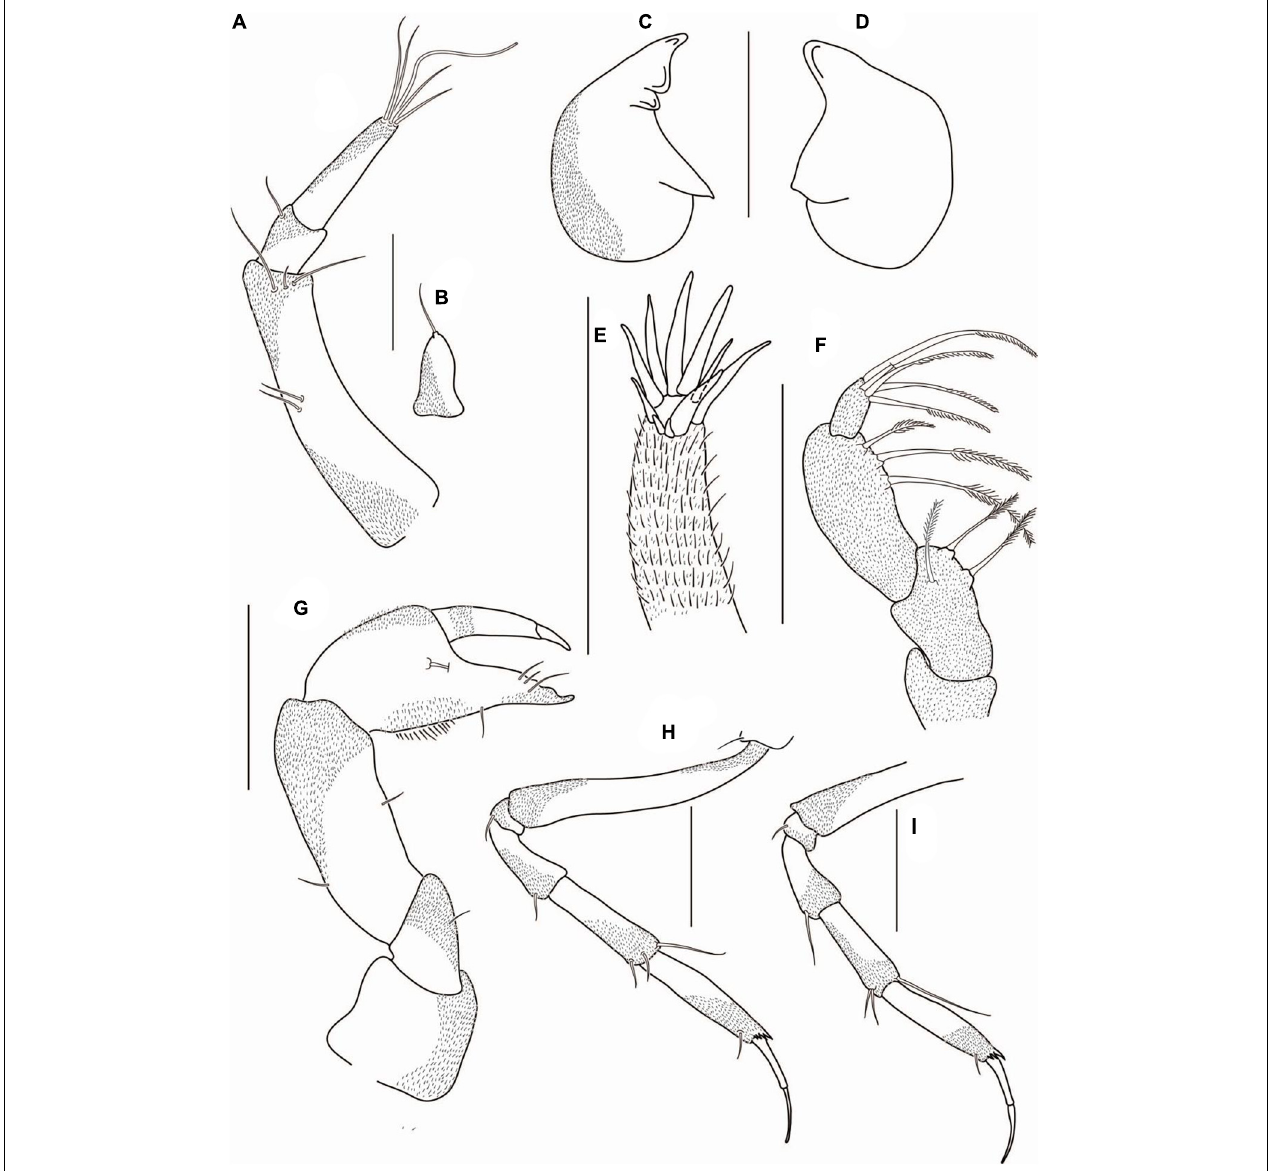
FIGURE 12 | Agathotanais oharai n. sp., neuter, paratype (NMV J 74742); (A) antennule; (B) antenna; (C) left mandible; (D) right mandible; (E) maxillule; (F) maxilliped; (G) cheliped; (H) pereopod-1; (I) pereopod-2. Scale bars: (A–F) = 10 µ m, (G–I) = 100 µ